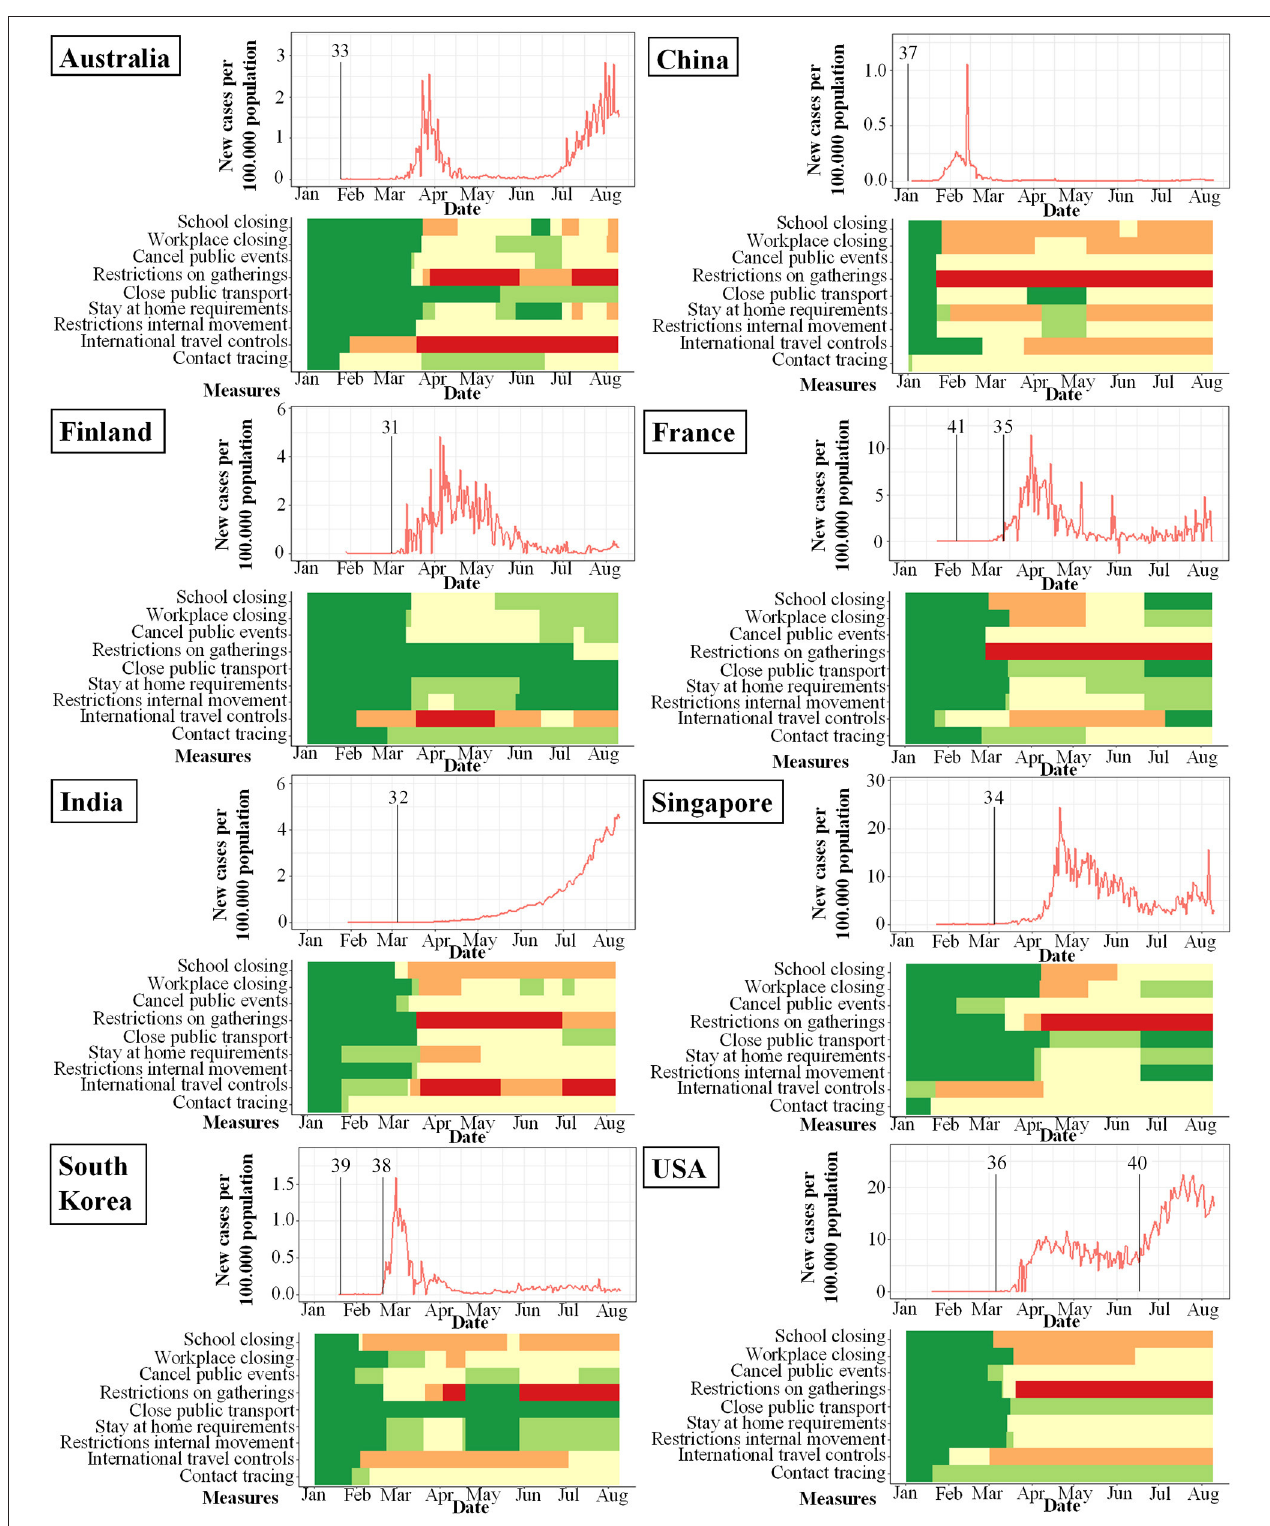
FIGURE 3 | Studies included in meta-analysis and their study start (indicated by vertical bar) in proportion to incidence of new infections with SARS-CoV-2 per 100.000 per day (y-axis) and changes over time (x-axis). Local response reactions to reduce spread of SARS-CoV-2 are shown below the x-axis in colored bars. Green bars mean no restrictions, red fullrestrictions, e.g., shut down of transport, no gatherings. Dataset of the figure is available in the Supplementary Material .